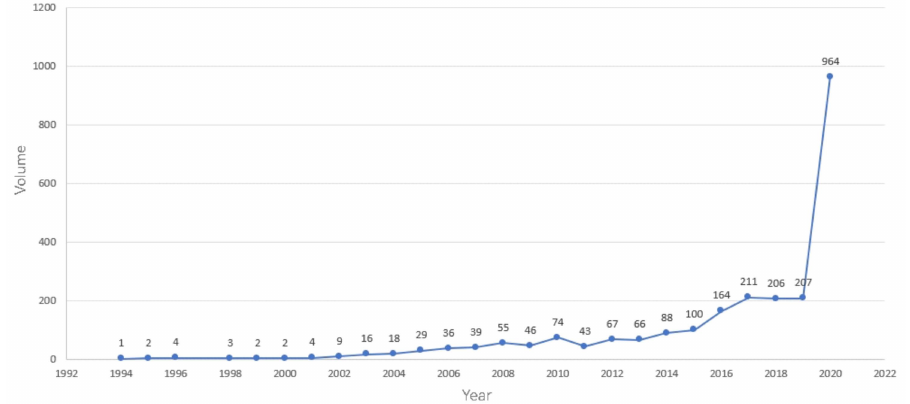
Figure 1. Literature volume of PHE from 1994 to